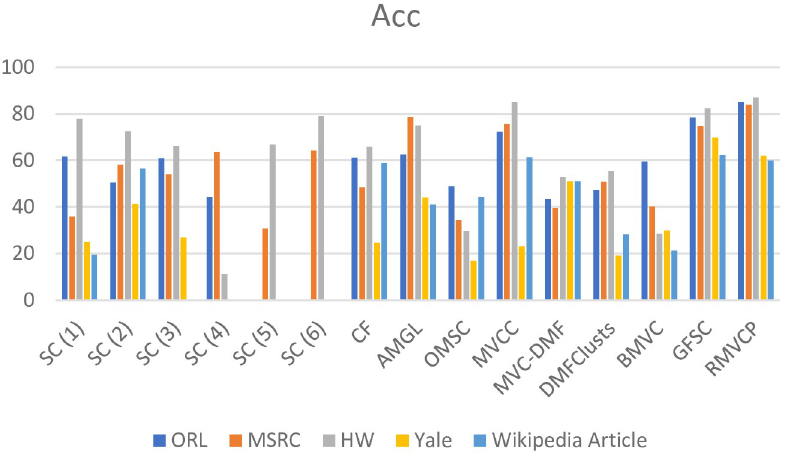
Fig 4. A histogram comparison of the Acc results of all algorithms on the five datasets.